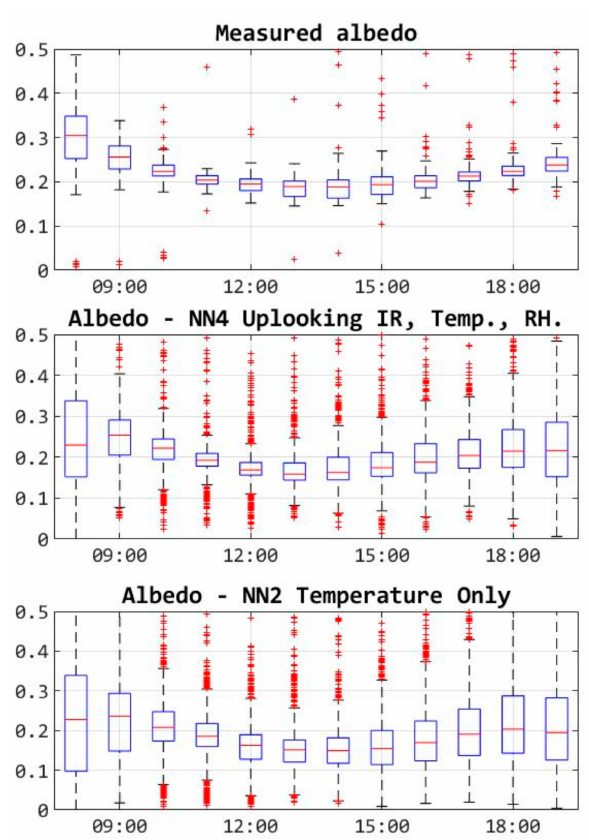
Figure 3. Measured and “synthetic” albedo—i.e., the ratio of upwelling to downwelling shortwave radiation, binned by hour of day. All data inclusive of training periods. Red hash markers indicate a relatively small number of outlier values beyond the 1st and fourth quartiles.